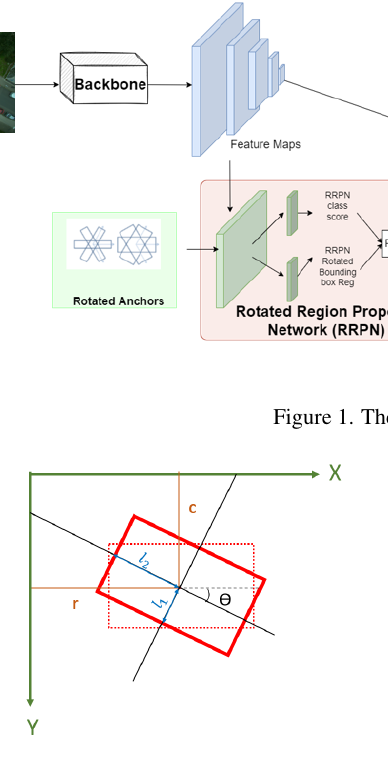
Figure 2. Rotated Bounding Box